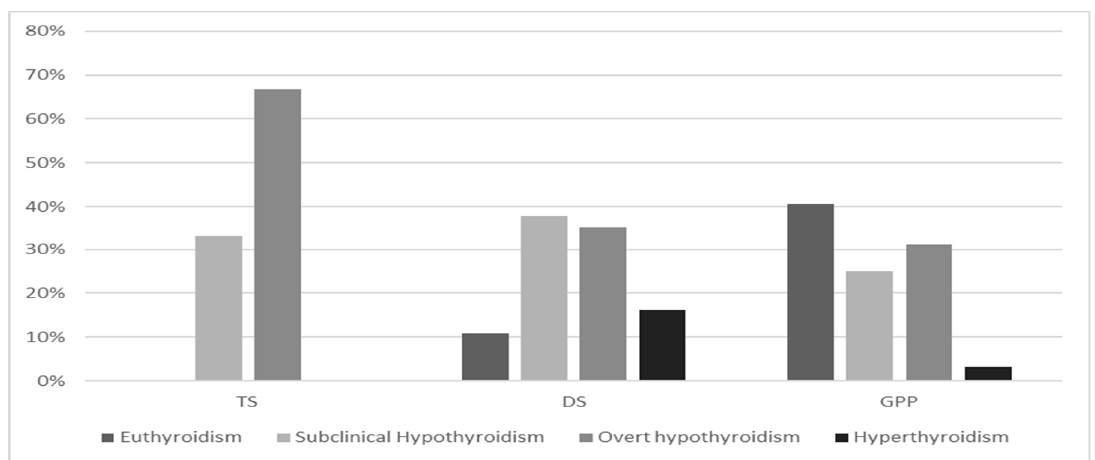
Figure 3. Prevalence (%) of different Hashimoto’s thyroiditis biochemical patterns after 5-year follow-up in Turner syndrome (TS), Down syndrome (DS) and general pediatric population (GPP) with an initial subclinical hypothyroidism presentation, according to references [30,53,65].